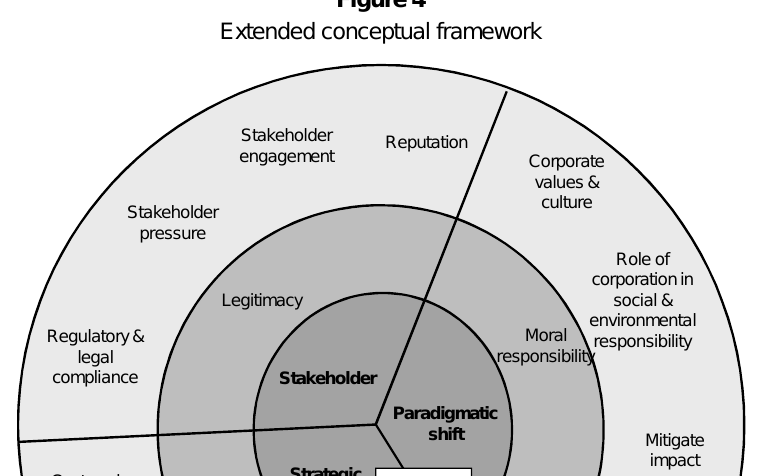
Extended conceptual